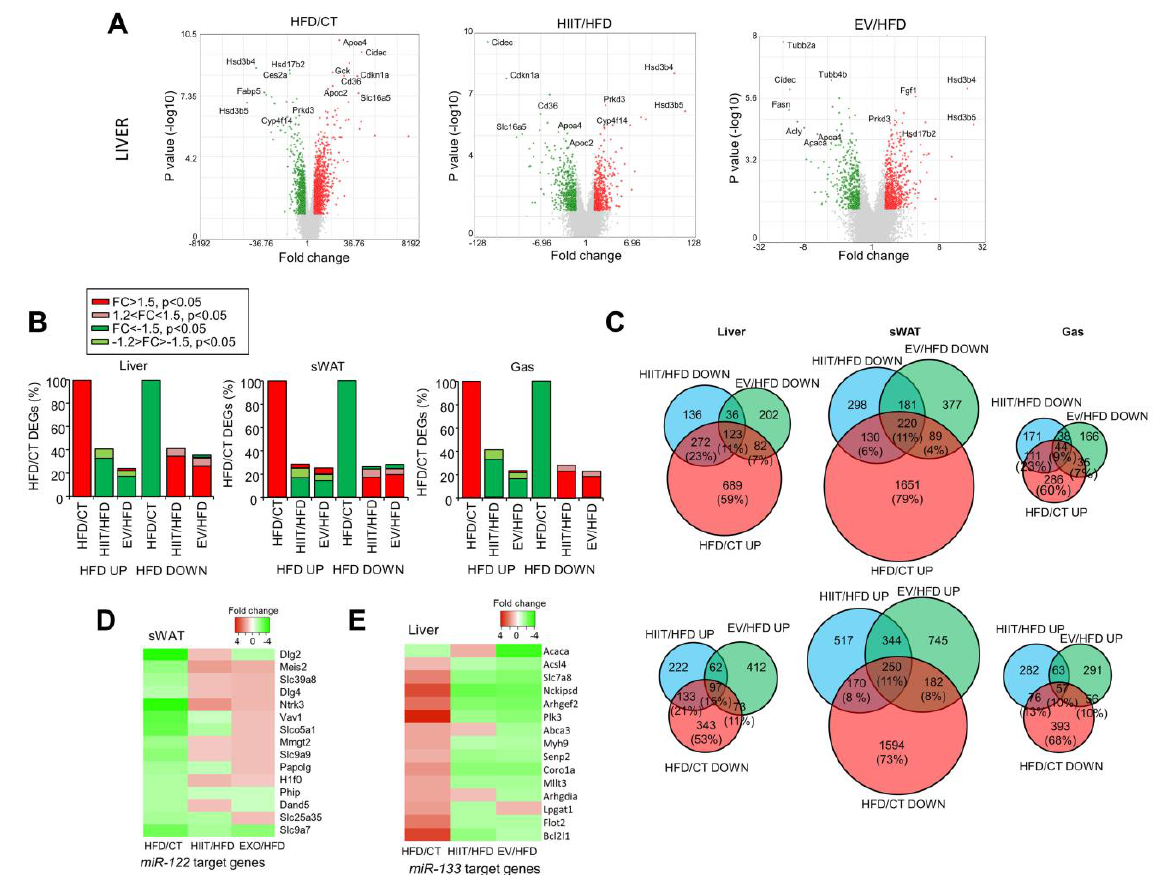
Figure 6. HIIT and EV-miRNAs partially reverse the alterations induced by diet: ( A ) Volcano plots depicting hepatic expression changes induced by the diet (HFD/CT, left panels) or HIIT and EV treatments (HIIT/HFD and EV/HFD; middle and right panels, respectively). ( B ) Histograms showing the percentages of differentially expressed genes in HFD reverted by the HIIT or EV treatments in the liver, sWAT, and gastrocnemius muscle. ( C ) Venn diagrams comparing differen- tially expressed genes that were upregulated (upper panels) or downregulated (lower panels) in the liver (left panels), sWAT (middle panels), and gastrocnemius muscle (right panels) of HFD mice vs. CT with differentially expressed genes that were downregulated or upregulated (respectively) by each of the treatments as compared with untreated HFD mice. ( D , E ) Target genes of miR-122 were downregulated in obese sWAT and upregulated by EV treatment ( D ), whereas miR-133 tar- gets were upregulated in the liver and downregulated by EV treatment ( E ). n = 4/group ( A – E ). The effects of EVs, although smaller (18% downregulated genes and 5% partially downregulated, with 23 upregulated), were comparable. The data for the sWAT and gastrocnemius were similar (Figure 6B). To analyze the extent to which the effects of HIIT